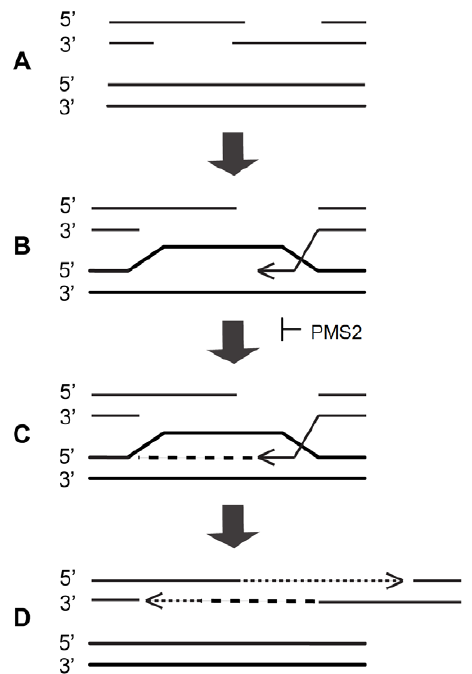
Figure 6. Formation of large expansions due to the absence of Pms2 during double strand break repair. (A) Repair of a double strand break within the repeat sequence begins with 5 9 to 3 9 resection of the free ends in the broken molecule (thin solid line). (B) The unpaired end of a strand in the broken molecule anneals to a complementary sequence in the template molecule (thick solid line). (C) In the absence of Pms2, DNA synthesis extends the invading strand (thin arrow). In the presence of Pms2, extension is inhibited. The break may be repaired by non-homologous end joining. (D) Erroneous alignment of the newly synthesized DNA (thick dashed line) during reannealing leaves a gap that is filled by another round of synthesis (thin dashed line), resulting in an expansion. The template molecule remains unchanged.